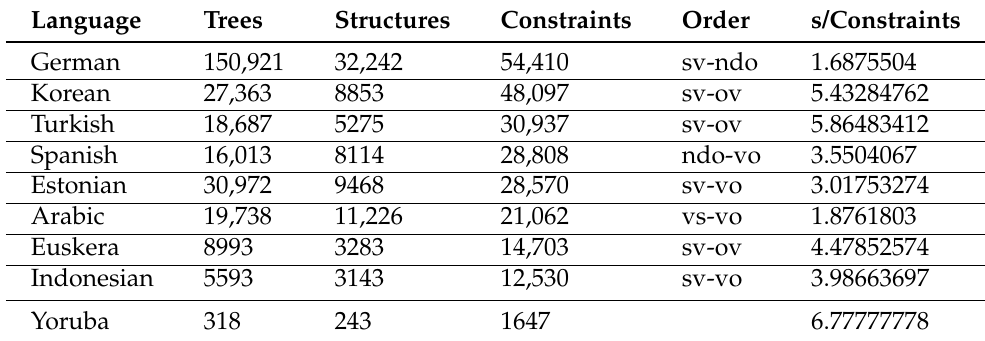
Table 3. Quantitative data of Marsagram.